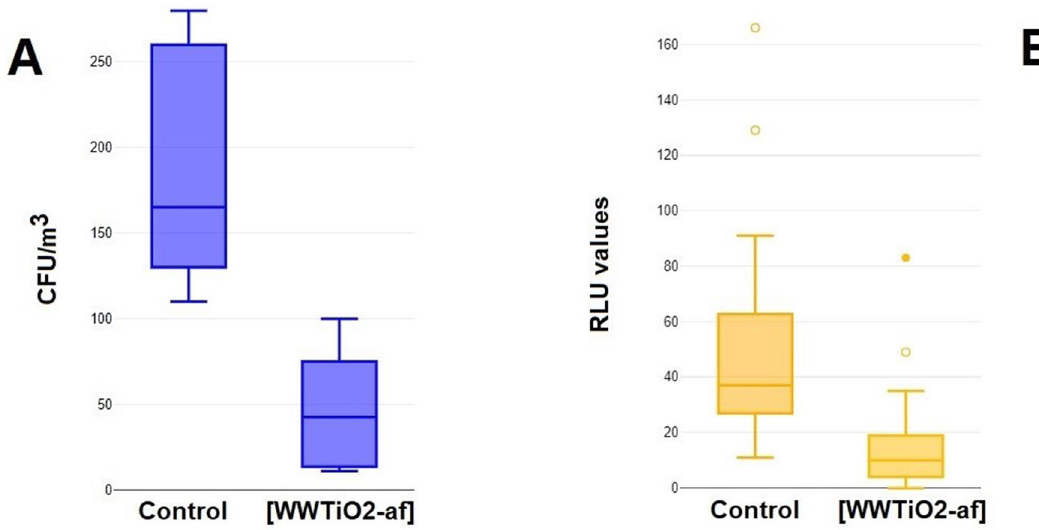
Figure 7. Comparison between reduction of microbial pollution in CFU/m 3 ( A ) and RLU ( B ) in a cumulative data of 83 data points. See text for